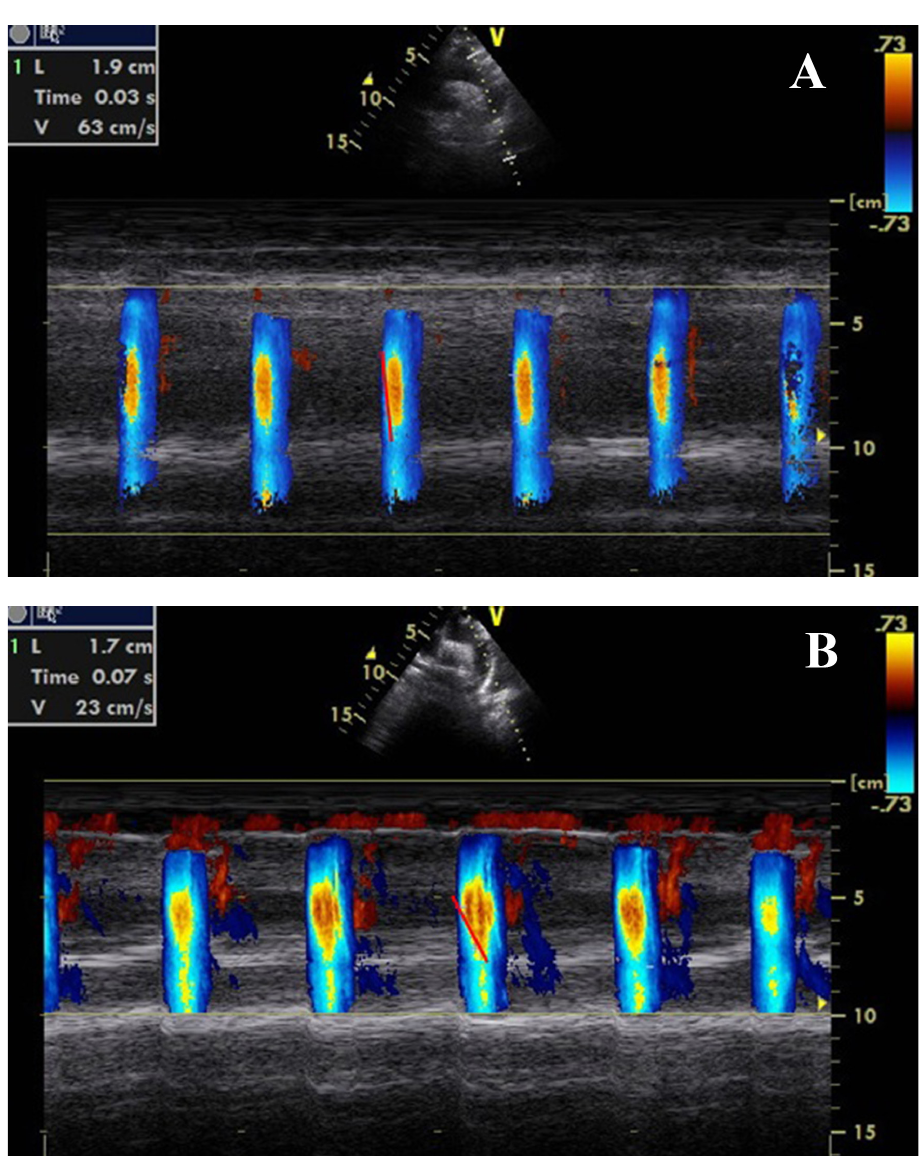
Fig. 1. Descending aorta propagation velocity in a low SS (A) and high SS (B)